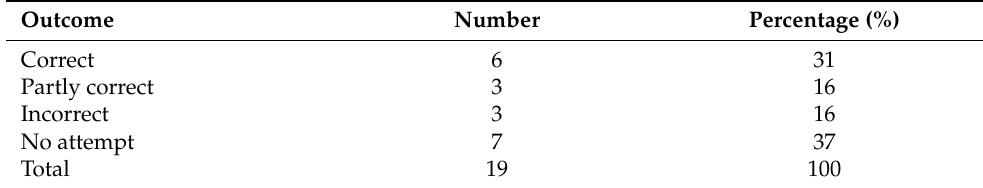
Table 5. Overall performances of students in solving the second word problem.